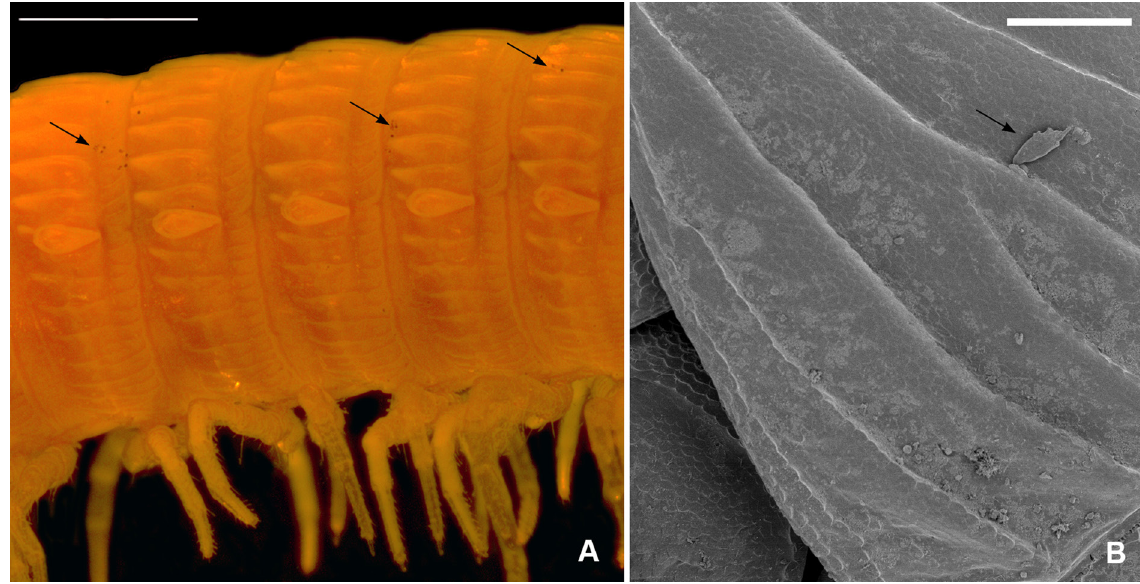
Fig. 12. Chiraziulus kaiseri (Mauriès, 1983), paratypes infected with ectoparasitic fungi of the genus Rickia Cavara, order Laboulbeniales. A . Arrows indicate black dots on the body rings corresponding to the insertion of the fungi. B . Scanning electron micrograph of the collum with one fungus (arrow). Scale bars: A = 1 mm; B = 100